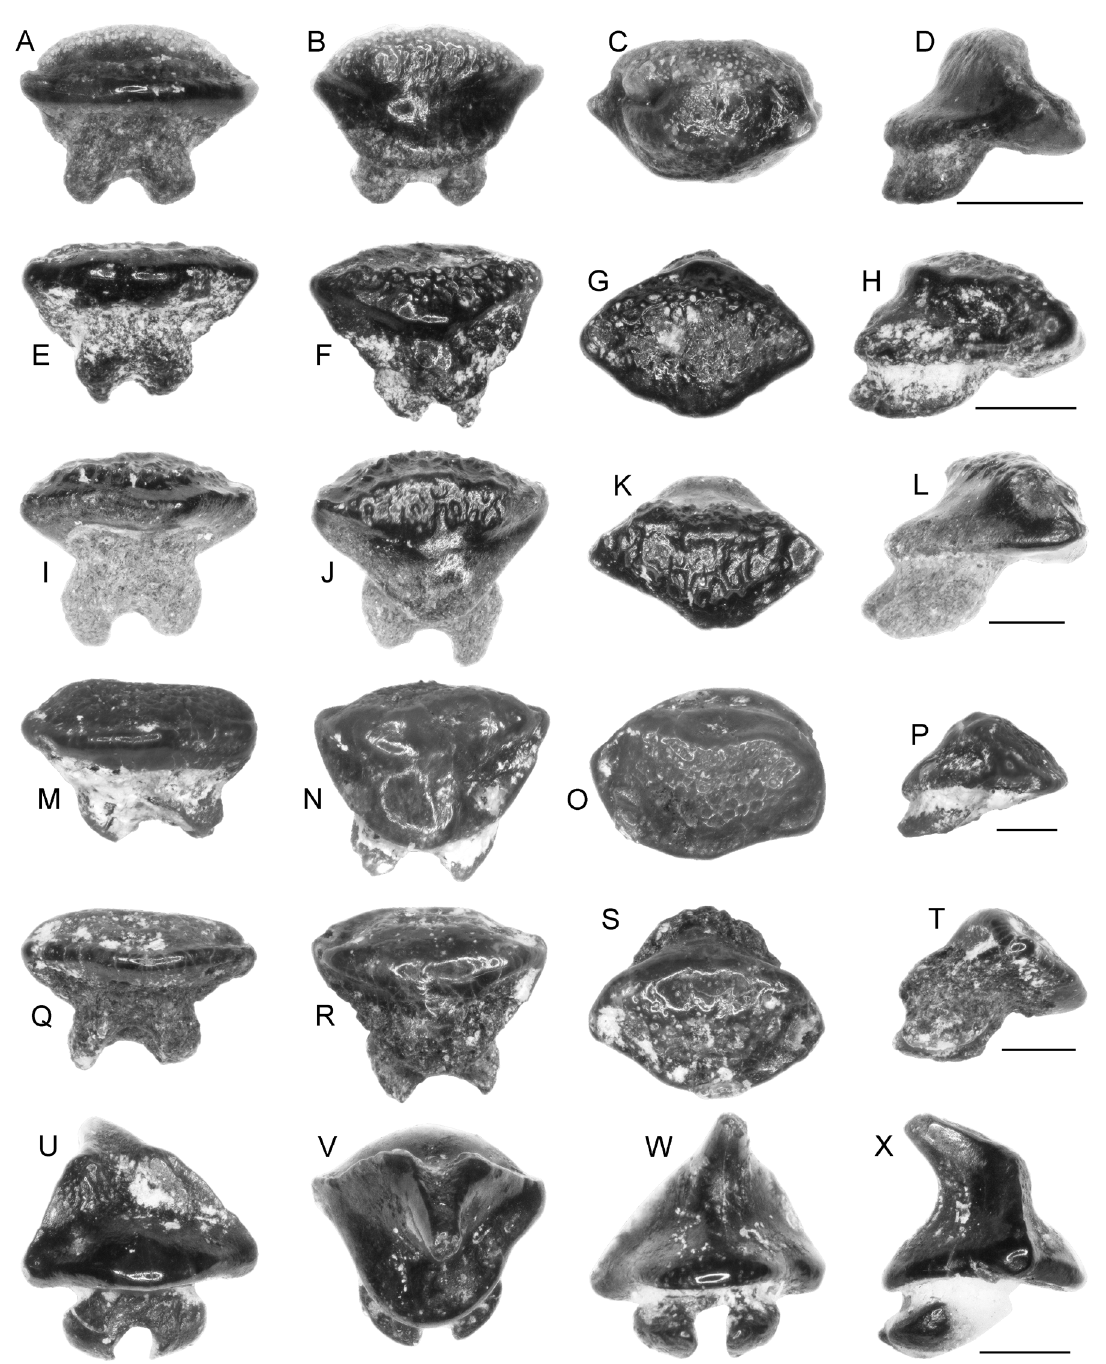
Fig. 40. “ Dasyatis ”, teeth. A–L . “ Dasyatis ” aff. D . charlisae Case, 1981. A–D . SC2012.47.242, basal Lisbon Formation. A . Basiolabial view. B . Oral view. C . Labial view. D . Profile view. E–H .